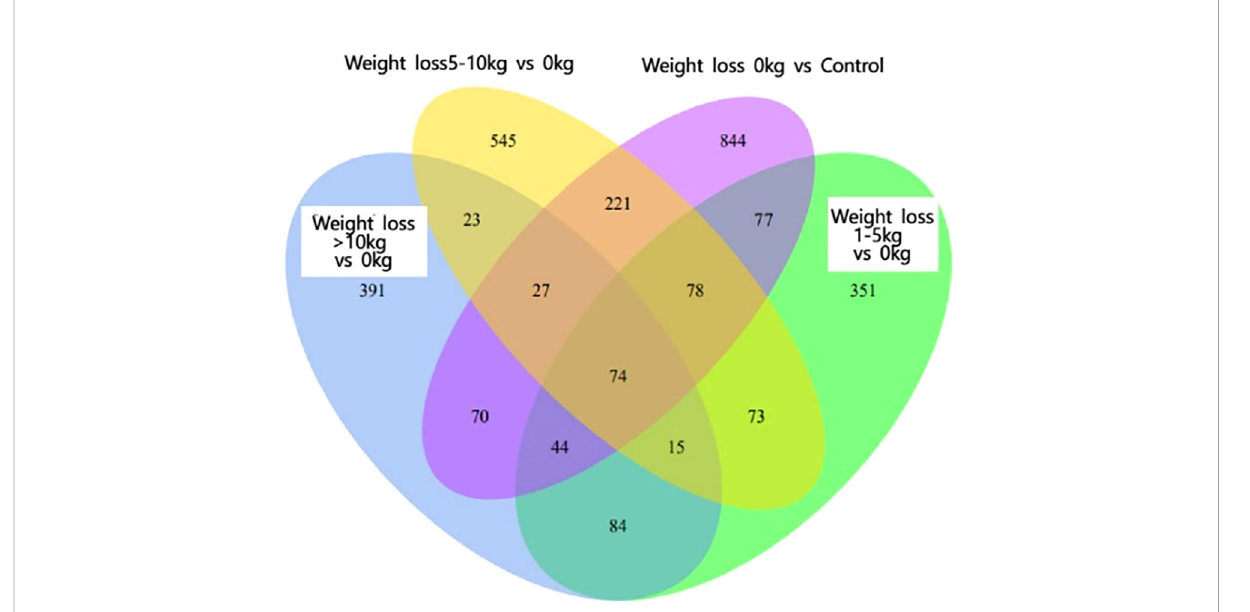
FIGURE 2 Venn2 Co-expressed differential